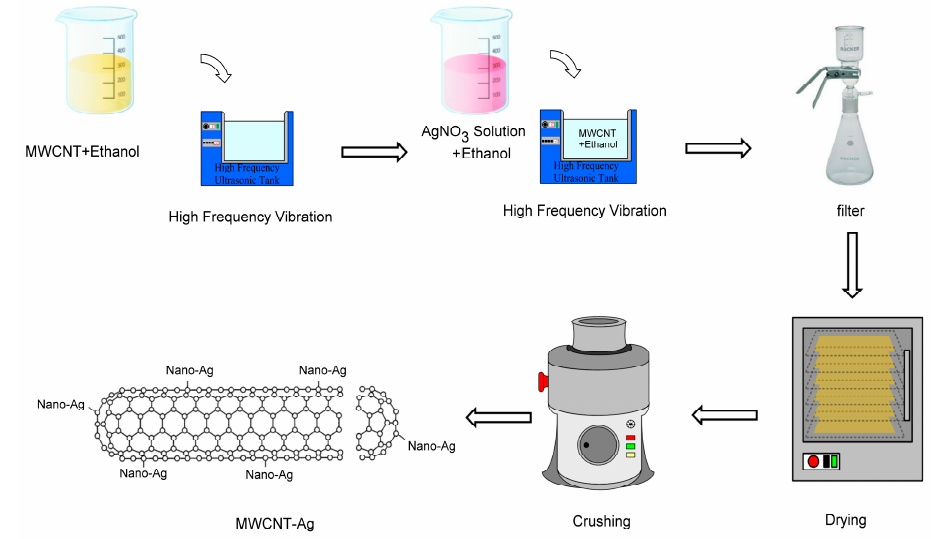
Figure 1. Nanosilver-doped multiwall carbon nanotube (MWCNT-Ag) synthesis.